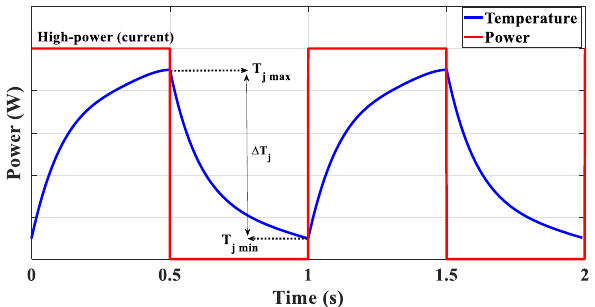
Figure 10. IGBT temperature variations under power cycling test.